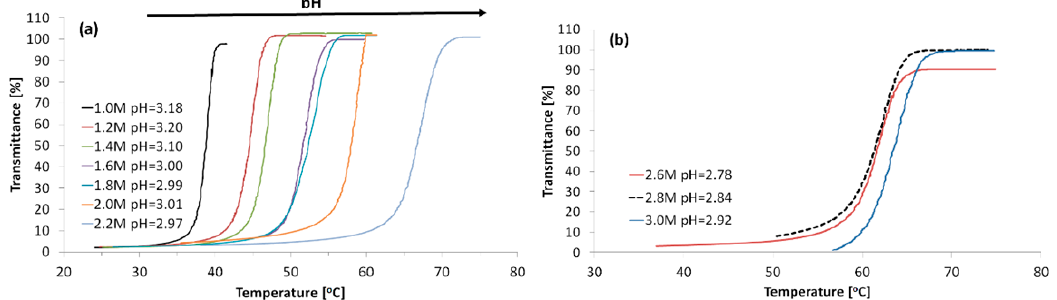
Figure 1. The cloud point temperature ( T CP ) curves for 0.25% L1 in KCl solutions with different concentrations without HCl ( a ) and after the addition of 140 µL HCl ( b ).